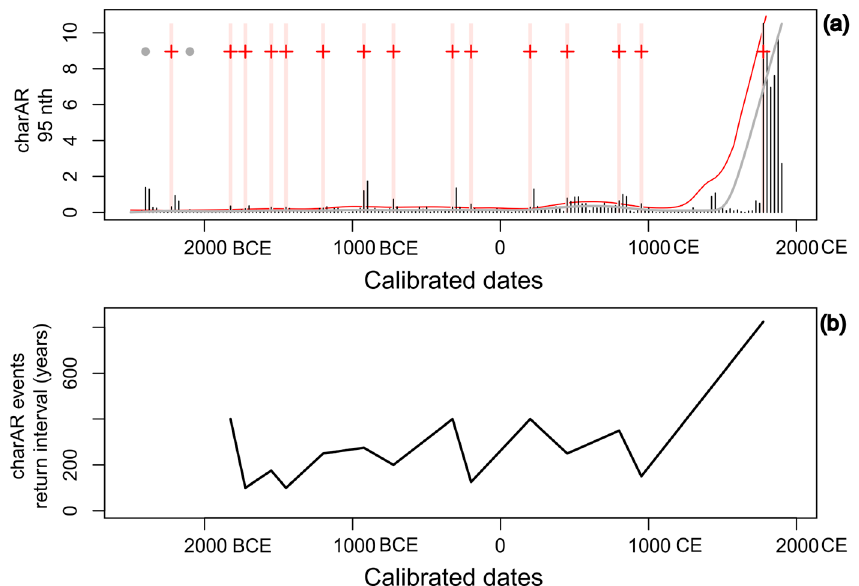
Figure 8. ( a ) Macroscopic charcoal accumulation rate (charAR, pieces cm − 2 yr − 1 ) interpolated to 25 years (grey bars), charcoal background modelled using a 500-year smoothing window (grey line), and final positive threshold values for peaks identification (red lines). Identified CHAR peaks are marked with “+” symbols; non-significant CHAR peaks marked with grey circles. ( b ) Fire return interval (yrs fi re − 1 ) values. BCE—Before Common Era, CE—Common Era.